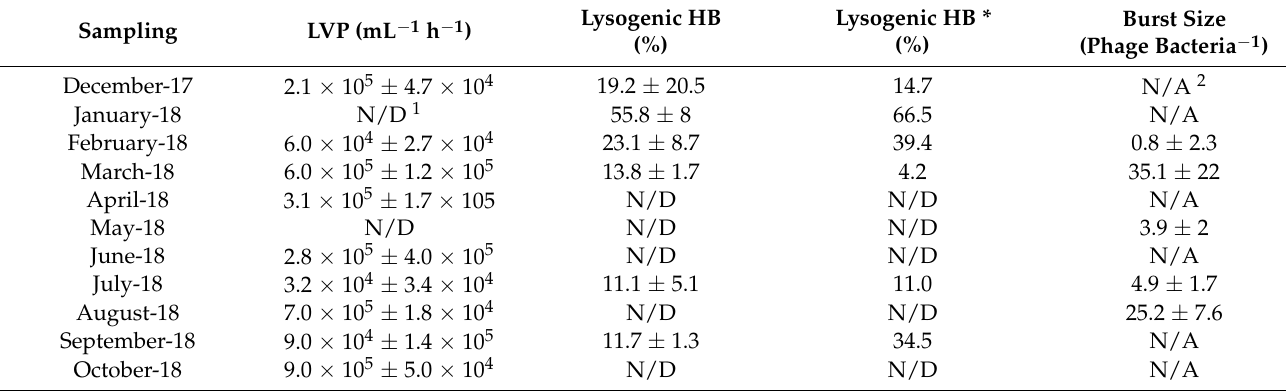
Table 2. Estimation of percentages of lysogenic heterotrophic bacteria (HB) and Lytic Viral Production (LVP), ± standard error of the replicates, based on induction by mitomycin C for monthly individual incubation experiments since